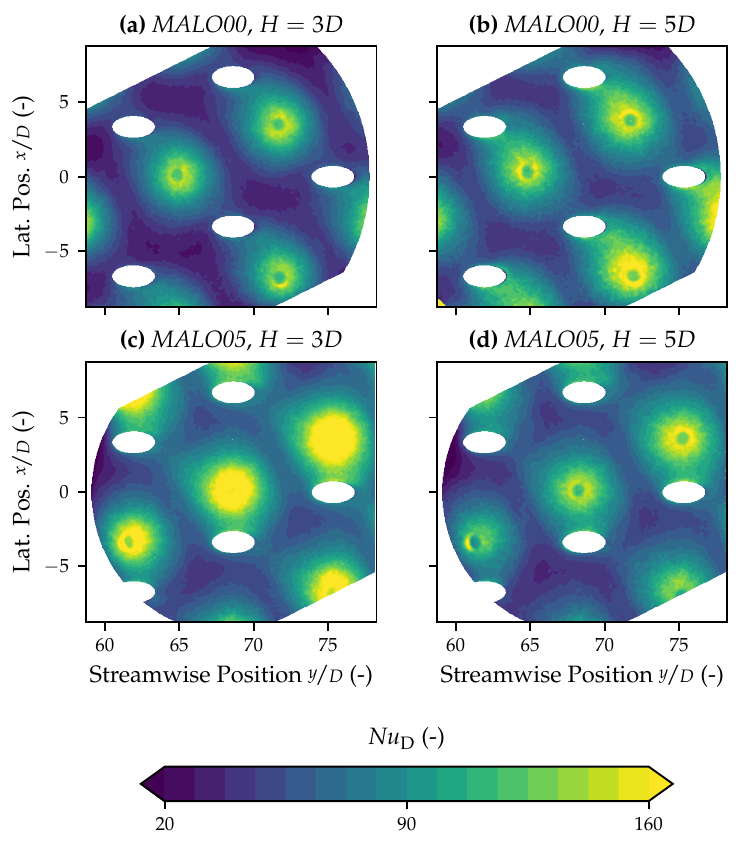
Figure 9. Nusselt number distributions on cavity side of effusion specimen for a high blowing ratio of M = 3. Rows show alignment; columns show different cavity